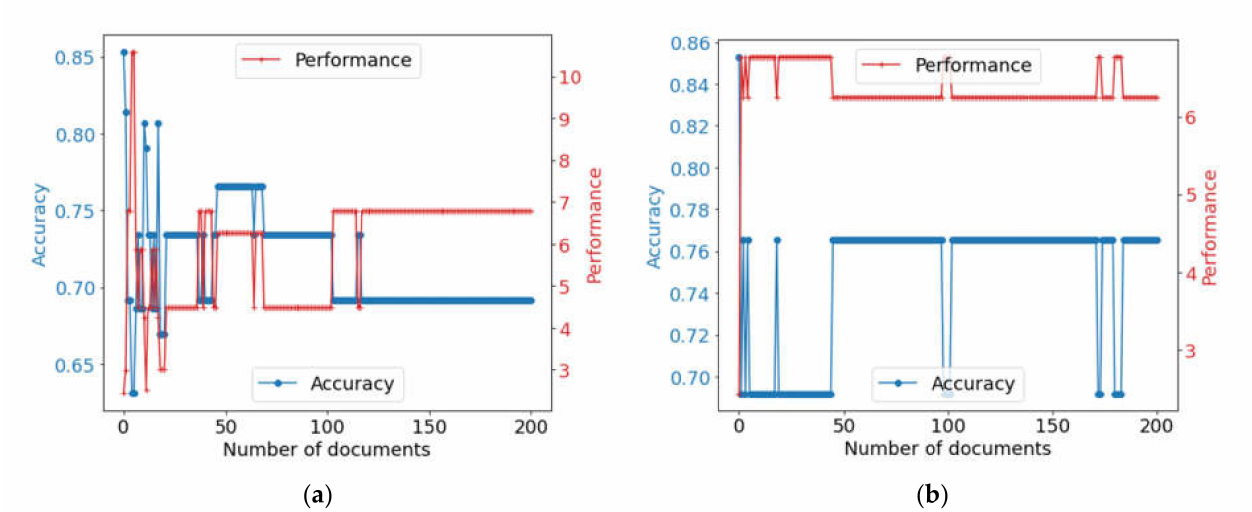
Figure 10. Case 3 auctioning results: ( a ) prioritization by accuracy, ( b ) prioritization by performance.